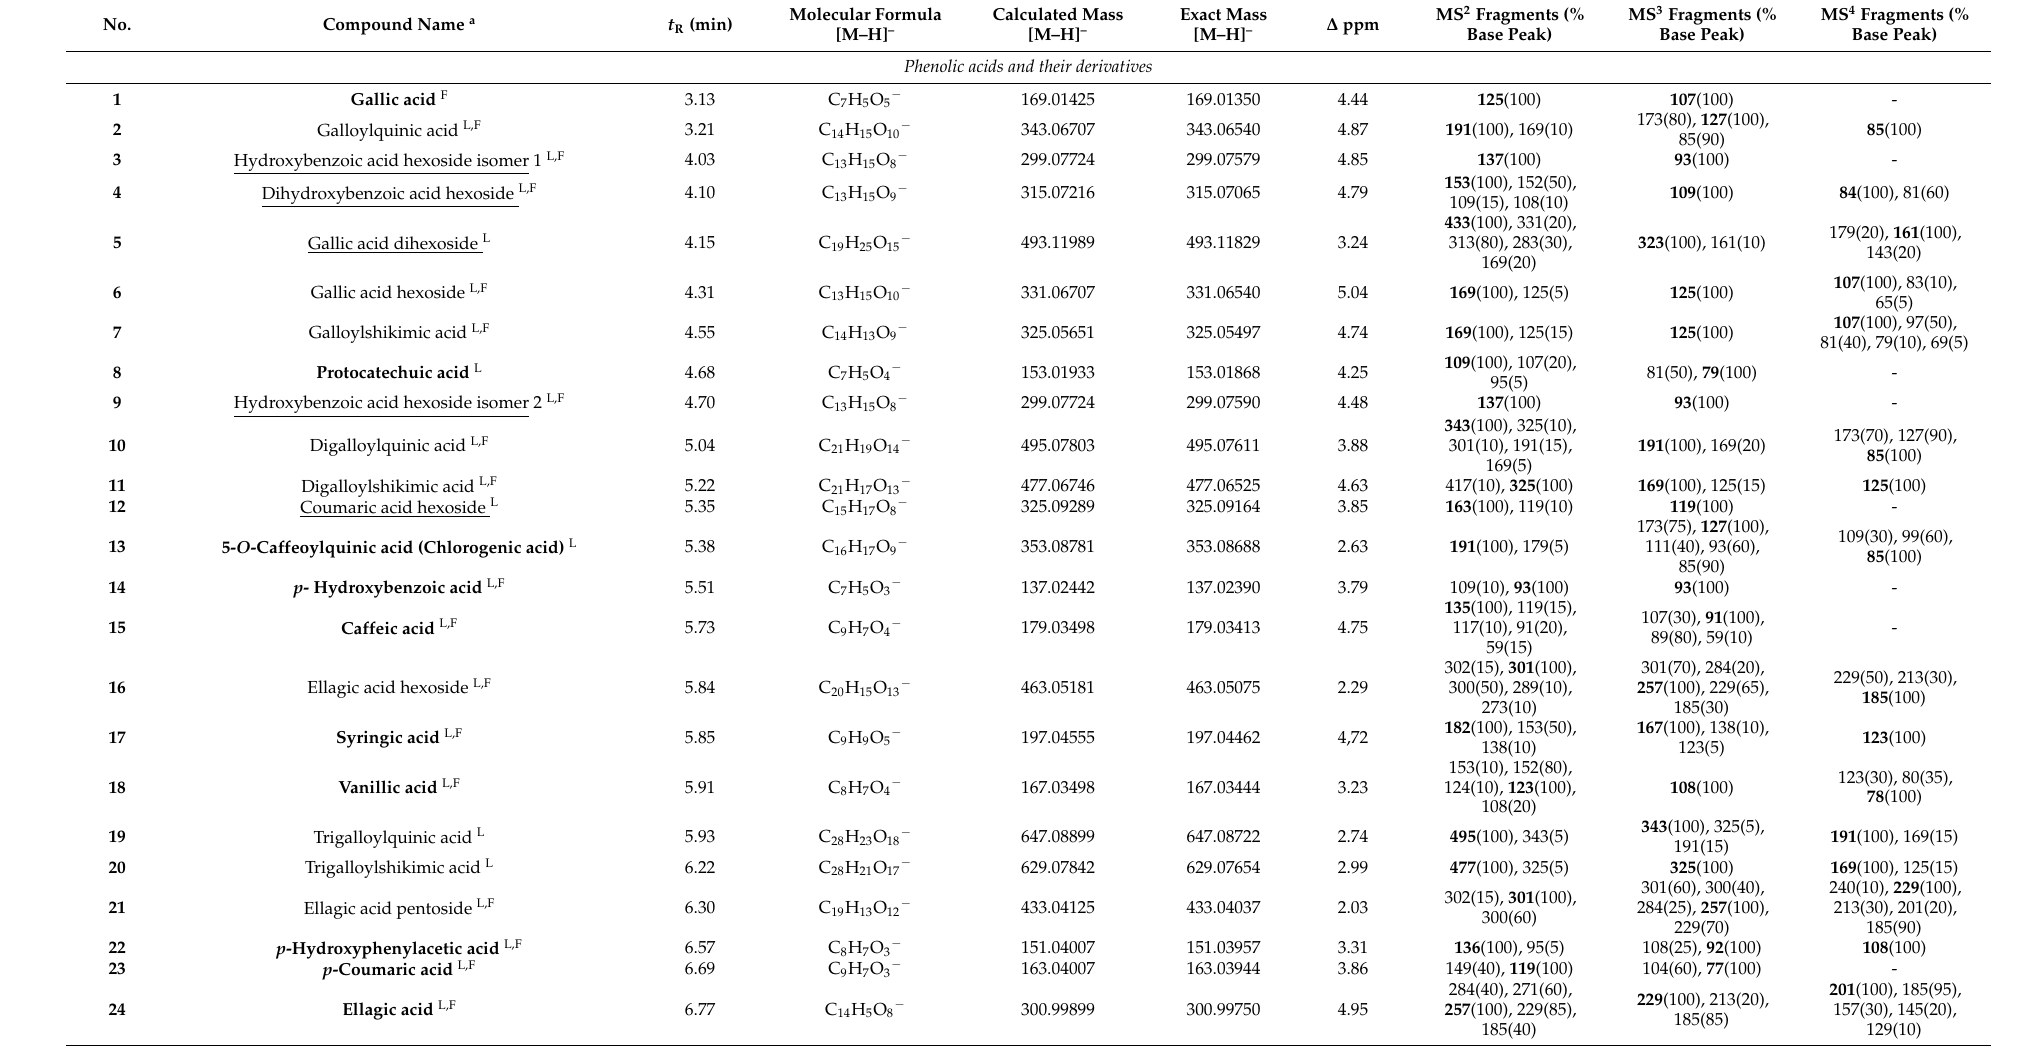
Table 1. Phytochemical fingerprint of strawberry tree ( Arbutus unedo L., Ericaceae) leaves and fruits from Croatia using UHPLC-LTQ Orbitrap